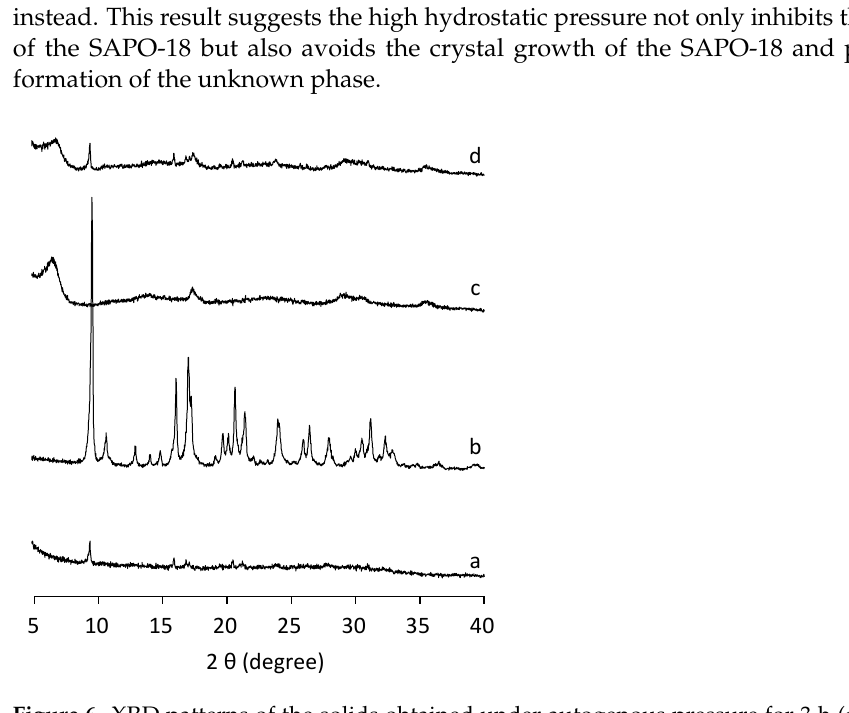
Figure 6. XRD patterns of the solids obtained under autogenous pressure for 3 h (a) and 24 h (b), under 200 MPa for 24 h (c) and under autogenous pressure for 3 h and 200 MPa for 21 h (d) using the diluted synthesis mixture (H 2 O/Al 2 O 3 = 50).